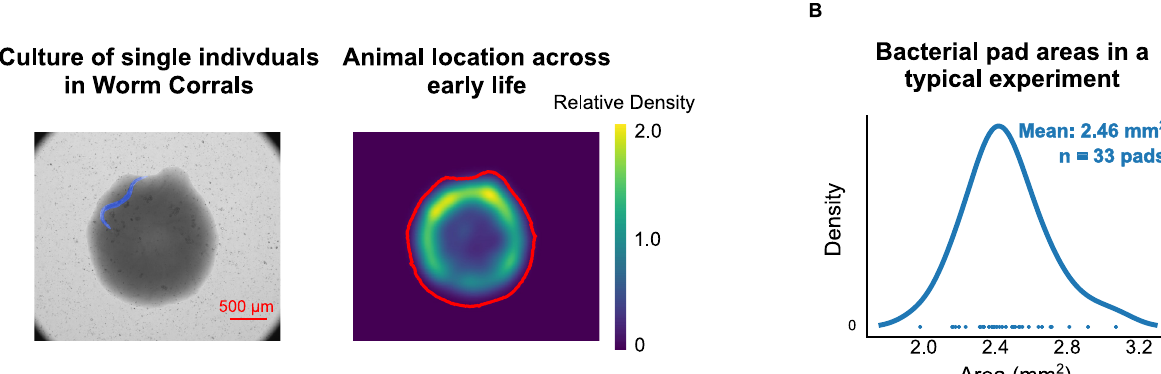
Fig 1. Experimental setup and correlation between second- and minute-scale movement. (A) Left panel , Imaging of single individuals in Worm Corrals were performed at regular intervals using standard brightfield imaging on a compound microscope. In each image, the region corresponding to a worm (blue region) and food pad were identified. Right panel , the animal’s location over the first six days of adulthood represented using a 2-dimensional kernel density plot of the centroid of the worm region. Most animals tended to spend most timepoints near the edge of the bacterial food pad where, due to the “coffee ring effect” [45], bacterial density is greatest. (B) Distribution of lawn area measurements from segmentation. The mean lawn area was ~2.5 mm 2 (equivalent to a circle with a radius of 0.88 mm/diameter of 1.76 mm).